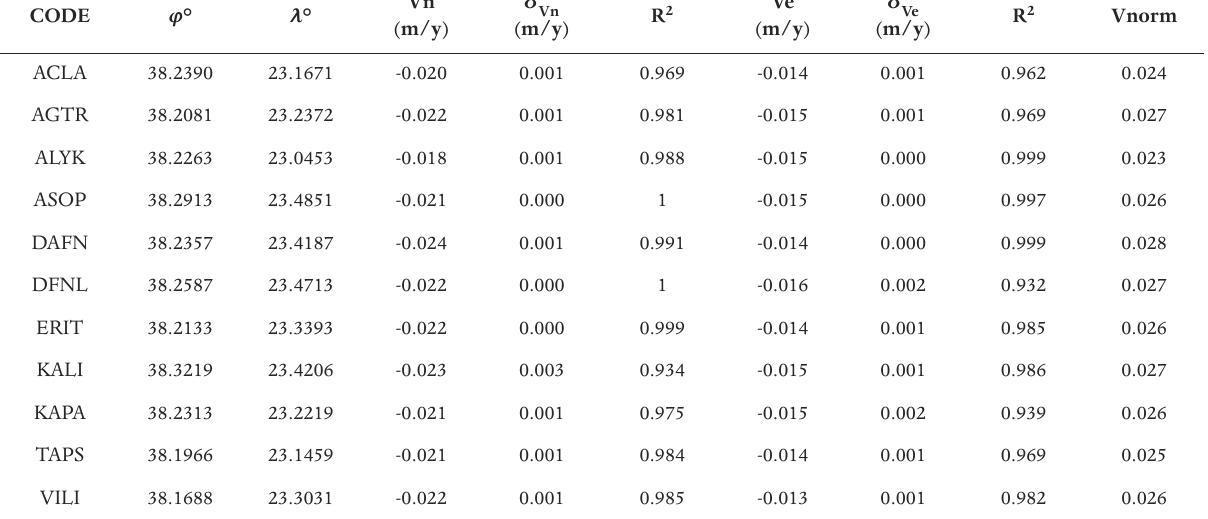
Table 1. Horizontal station velocities with respect to a stable Europe. V east component. v indicates standard deviation of velocity